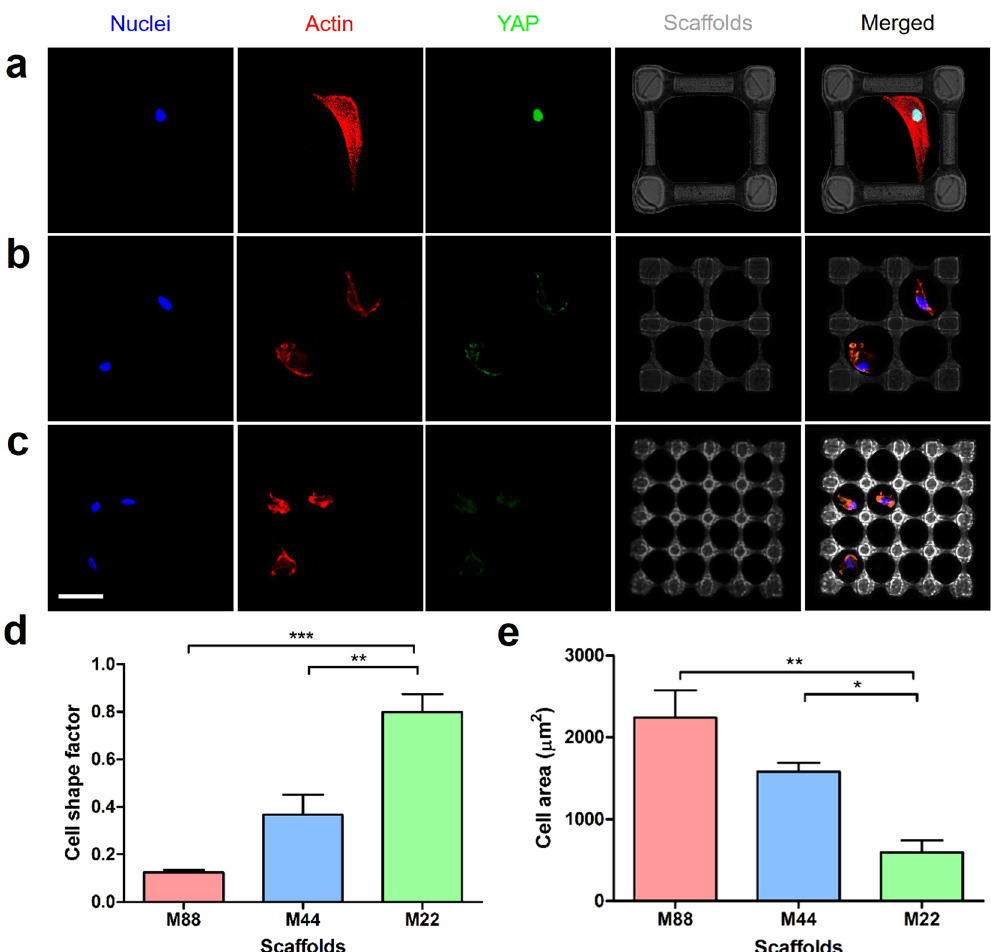
Figure 4. Fluorescent images of the hMSCs cultured in the 3D cubic microscaffolds with different cubicle sizes: ( a ) 88 × 88 μ m 2 (“M88”), ( b ) 44 × 44 μ m 2 (“M44”), and ( c ) 22 × 22 μ m 2 (“M22”) for 24 h; scale bar = 50 μ m. ( d ) Average cell shape factors and ( e ) average cell area of hMSCs cultured in the microscaffolds. * p < 0.05, ** p < 0.01, *** p <